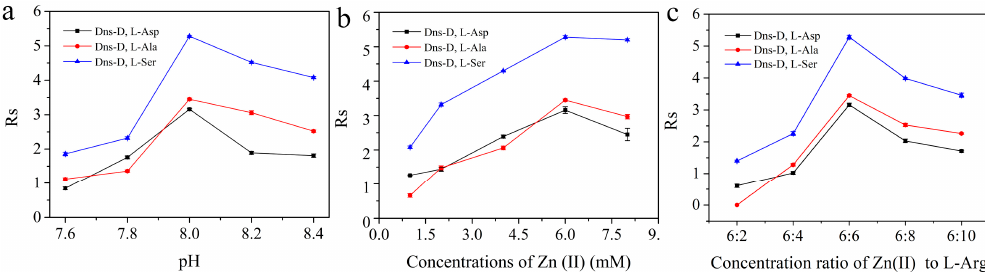
Figure 4. Effects of buffer pH ( a ), Zn(II) concentration ( b ), and the concentration ratio of Zn(II) to L-Arg ( c ) on the resolution of Dns-D,L-AAs. Chiral ligand exchange capillary electrochromatog- of Dns-D,L-AAs. Chiral ligand exchange capillary electrochromatography conditions, 100.0 mM boric acid, 10.0 mM raphy conditions, 100.0 mM boric acid, 10.0 mM ammonium acetate at different pH and concentra- ammonium acetate at different pH and concentrations of Zn(II) and L-Arg. Other conditions are the same as Figure tions of Zn(II) and L-Arg. Other conditions are the same as Figure 3.